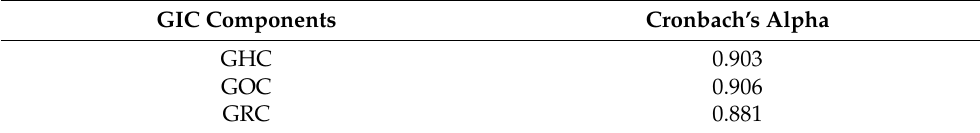
Table 1. Results of Cronbach’s Alpha.